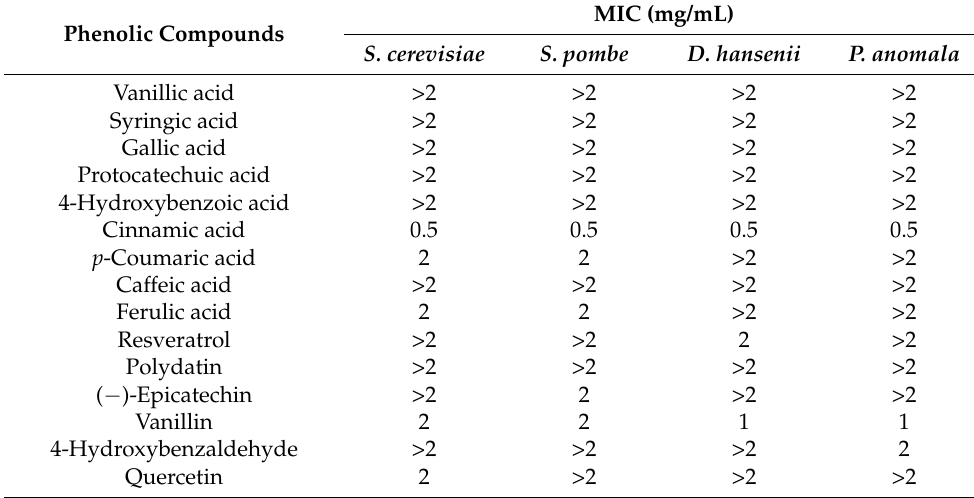
Minimum Inhibitory Concentration (MIC) of phenolic compounds against food- contaminating